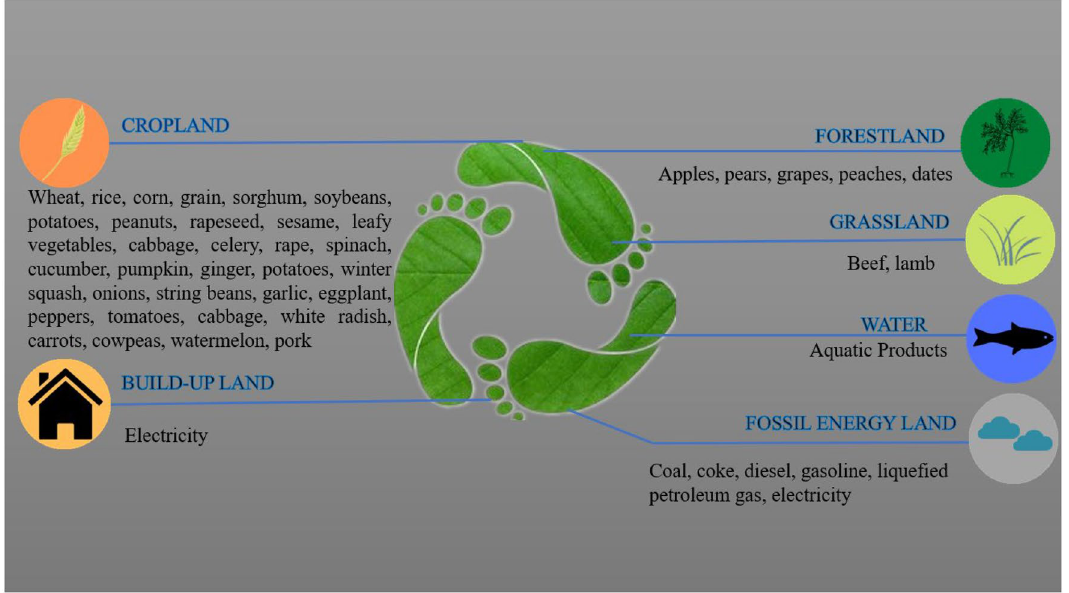
Figure 3. Traditional ecological footprint consumption accounts in Dongying city. This paper uses the carbon footprint to improve the fossil energy footprint of the traditional ecological footprint.